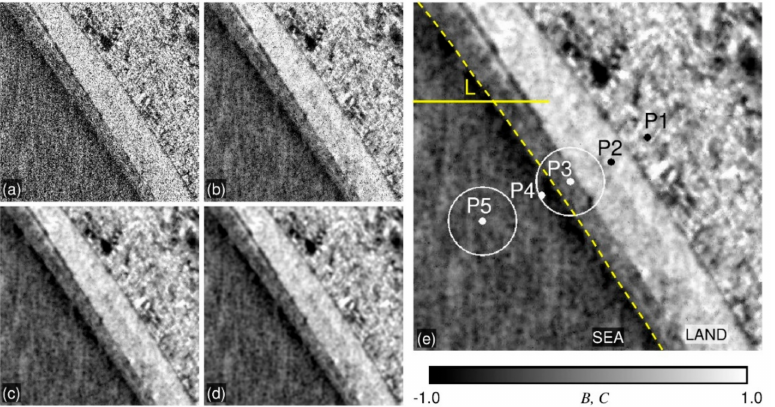
Figure 2. Examples of modified SAR images of ( a ) normalized backscattering coefficient, B ; ( b – d ) transferred C values with σ 2 = 1, 3, and 10, respectively. ( e ) The enlarged image of ( c ) with indications of the shoreline (dashed line), line L , and points P1, P2, P3, P4, and P5. The area of the image is indicated by a rectangular frame in Figure